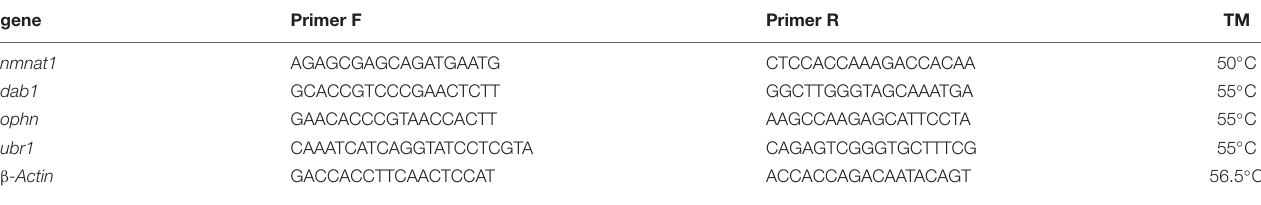
TABLE 2 | Primers used for